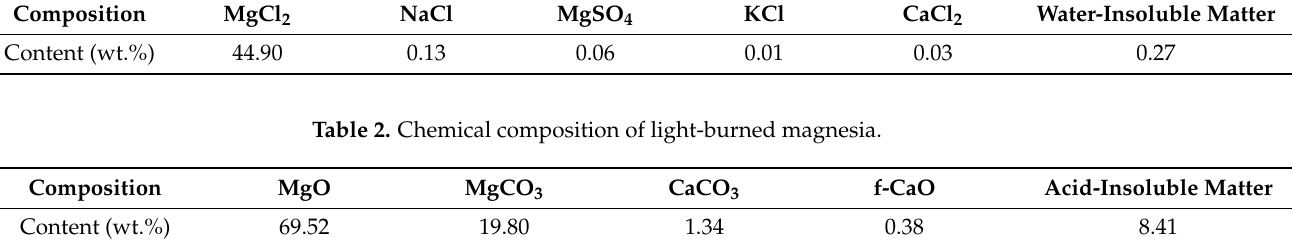
Table 1. Chemical composition of bischofite.